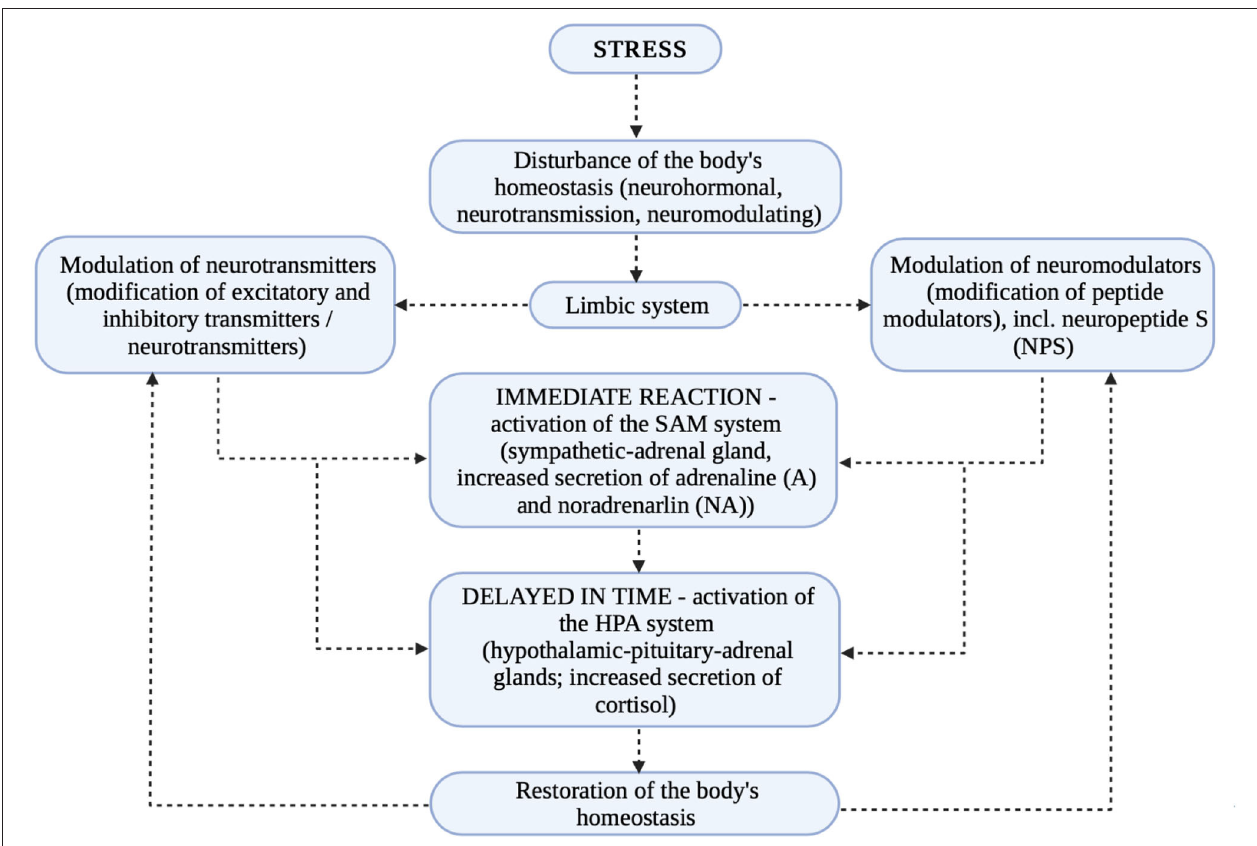
FIGURE 3 | Mechanism of the stress reaction (1–18, 22–25, 29–32, 34, 35).